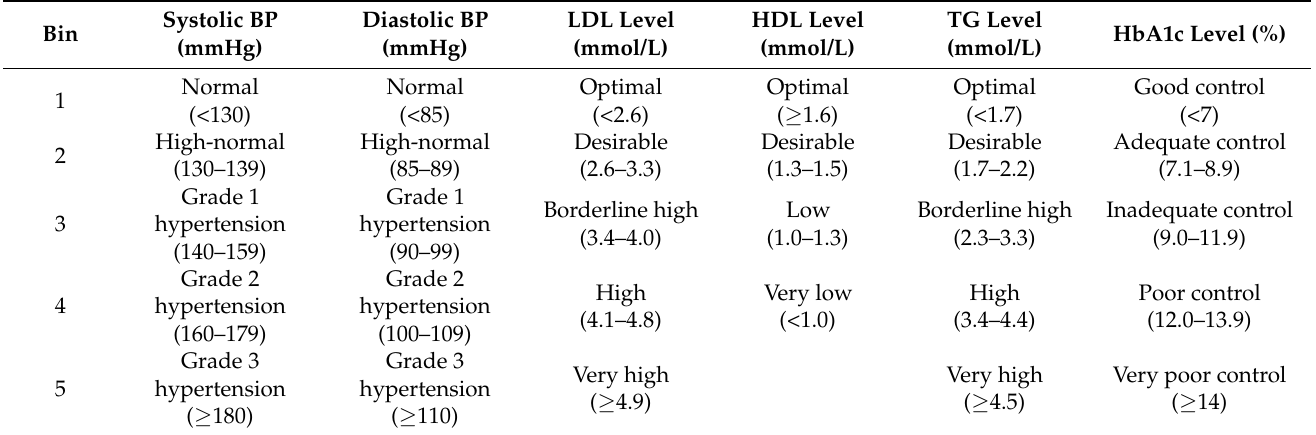
Table 5. Range of laboratory test results for each bin.